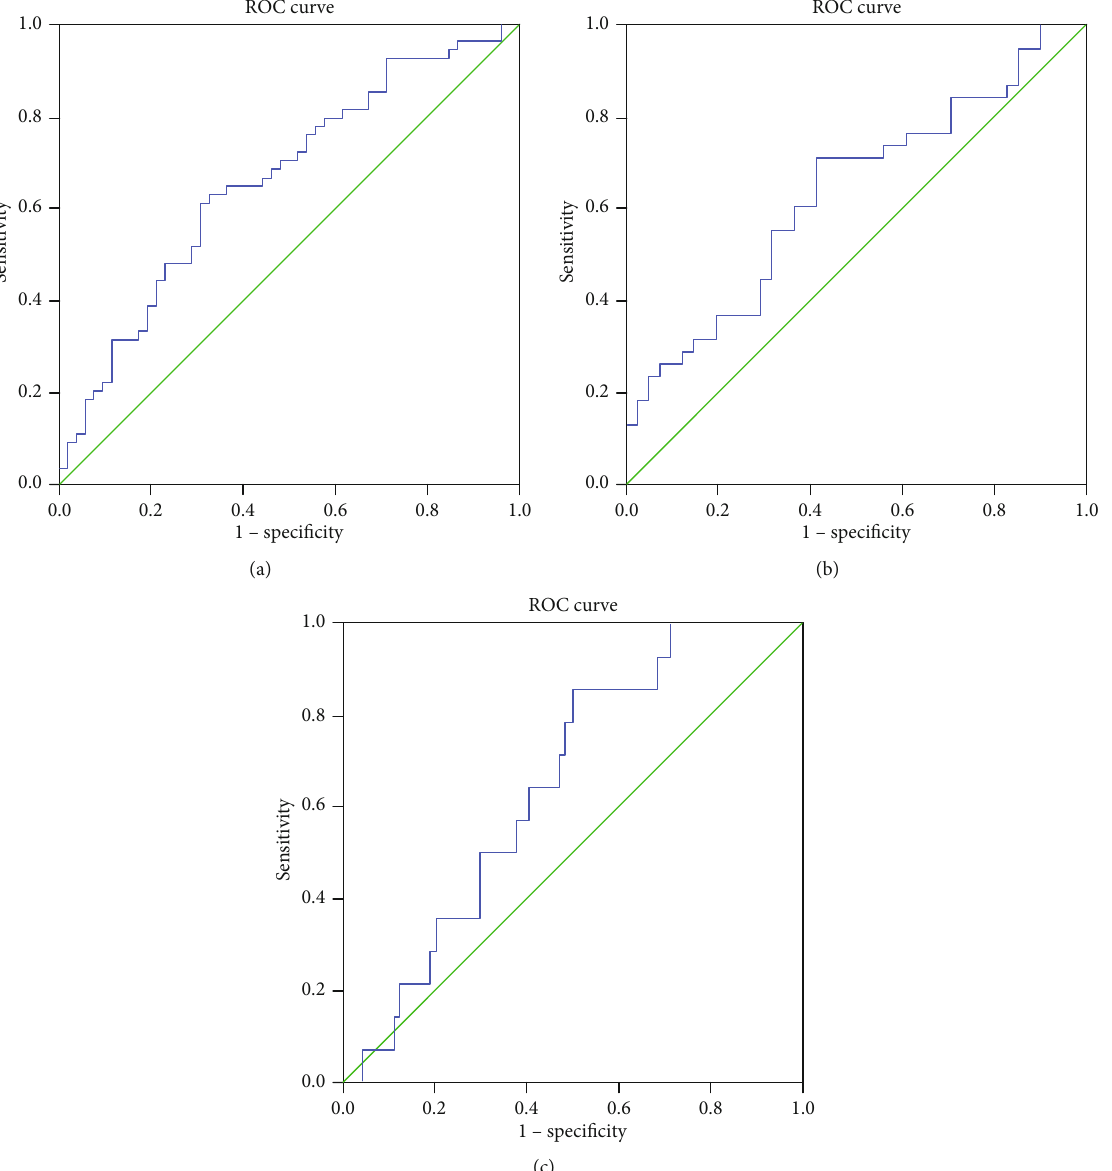
Figure 3: (a) ROC analysis of circulating omentin-1 to indicate osteoporosis for all subjects. AUC = 0 : 661 ; 95% CI: 0.558 – 0.765; P = 0 : 004 ; identi fi ed omentin − 1 cutoff value = 15 : 28ng/mL ; Youdenindex = 0 : 284 ; sensitivity: 63.0%; speci fi city: 67.3%. (b) ROC analysis of circulating omentin-1 to indicate osteoporosis for female subjects. AUC = 0 : 634 ; 95% CI: 0.511 – 0.757; P = 0 : 040 ; identi fi ed omentin − 1 cutoff value = 15 : 37ng/mL ; Youdenindex = 0 : 296 ; sensitivity: 71.1%; speci fi city: 58.5%. (c) ROC analysis of circulating omentin-1 to indicate osteoporosis for male subjects. AUC = 0 : 654 ; 95% CI: 0.524 – 0.784; P = 0 : 068